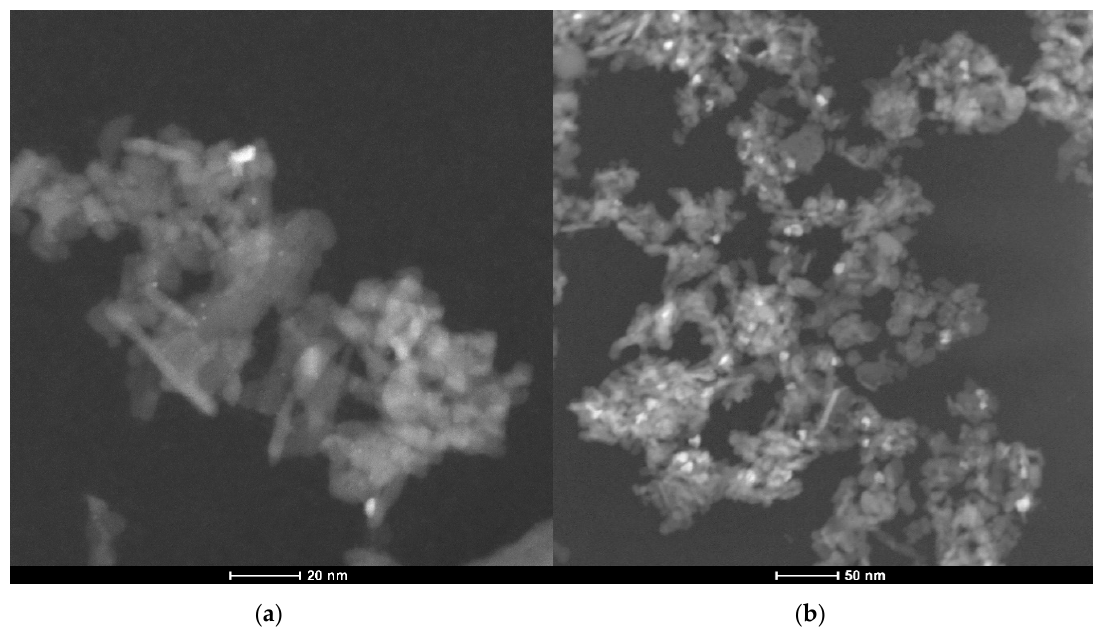
Figure 2. Δ T 50 and Δ T 100 for different light-off measurements for PdO/Al 2 O 3 in 3200 ppm CH 4 , 10% O 2 and balance N 2 in the absence of steam and in the presence of different water concentrations, with a temperature ramp of 3 K min − 1 . GHSV = 140,000 h − 1 .